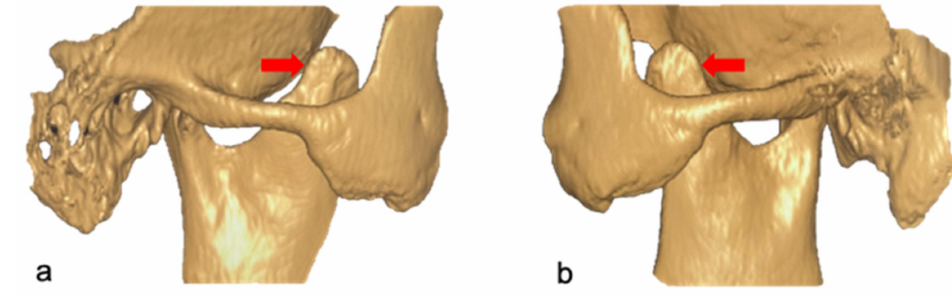
Figure 6. ( a , b ) CBCT examinations at closed mouth: ( a ) right side; ( b ) left side (age 14).